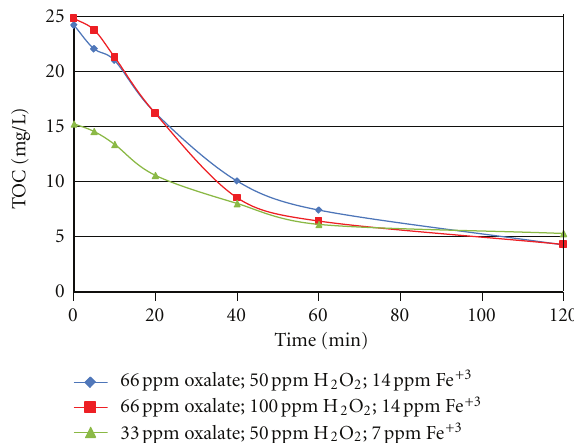
Figure 11: Homogeneous photocatalysis of mepiquat chloride using the ferrioxalate agent (initial conditions: 10ppm mepiquat chloride, VIS